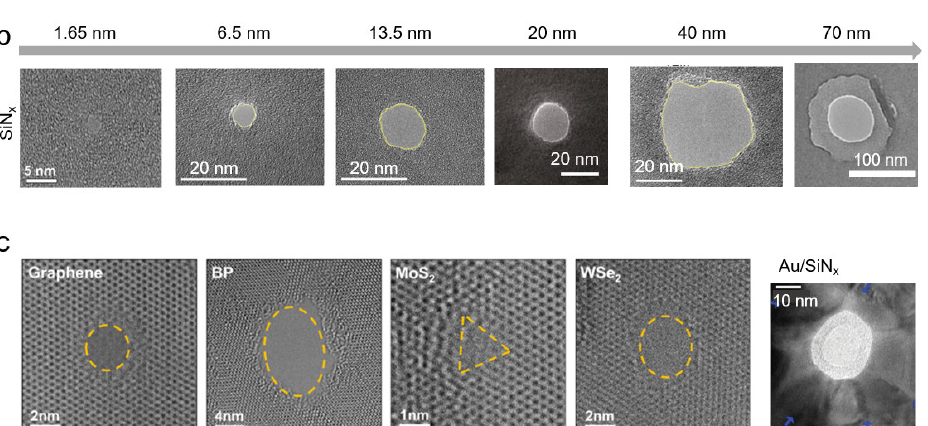
Figure 2. Controlled breakdown (CBD) applied in nanopore fabrication. ( a ) Schematic illustration of CBD-forming nanopore process Ref. [83] (not to scale). The red and blue curves represent the applied voltage and measured current, respectively. ( b ) CBD nanopores in SiN x membrane ranging from 1.65 nm to 70 nm in diameter. Reprinted with permission from Ref. [10]. Copyright 2018 American Chemical Society. Reprinted with permission from Ref. [91]. Reprinted with permission from Ref. [118]. ( c ) CBD nanopores in different 2D membranes including Graphene, black phosphorus (BP), molybdenum disulfide (MoS 2 ), and tungsten diselenide (WSe 2 ), along with a nanopore formed in a gold-coated SiN x membrane. Reprinted with permission from Ref. [119]. Copyright 2018 American Chemical Society. Adapted with permission from [120]. Copyright 2014 John Wiley & Sons, Inc.